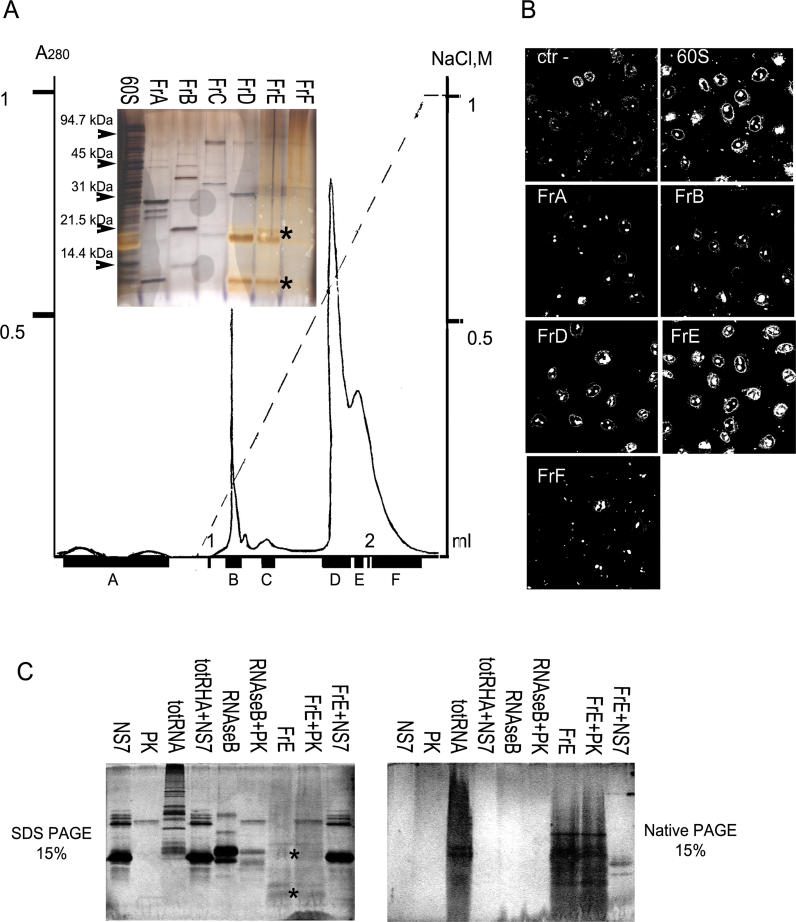
Purification and Characterization of the Active Component in the 60S(A) Chromatographic profile obtained after hydrophobic interaction and ion exchange chromatography of the original 60S (see Materials and Methods). Individual fractions were analyzed by SDS-PAGE and silver staining (60S, 20-μg protein/lane, and Fractions (Fr) A to F, 10-μg protein/lane). Asterisks indicate the two bands present in FrE.(B) Nuclear import of YOYO-1–labelled RTCs in permeabilized HeLa cells in the presence of 1× energy-regenerating system, 60S, fractions FrA to FrF (0.5 mg/ml) or buffer (ctr –).(C) The two bands in FrE are nucleic acids. Equal amounts of FrE were subjected to proteinase K (PK) or nuclease S7 (NS7) treatment (see Materials and Methods) and analyzed by SDS-PAGE or native PAGE followed by silver staining. Total HeLa RNA (totRNA) and RNAse B were used as controls for nuclease or proteinase digestions, respectively.